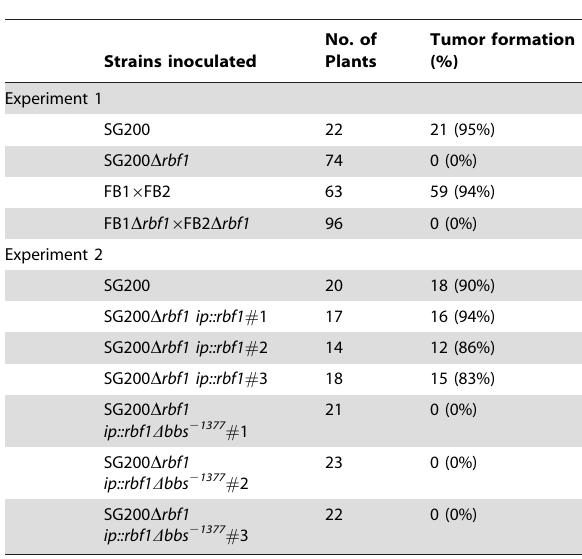
Table 1. Pathogenicity of rbf1 deletion